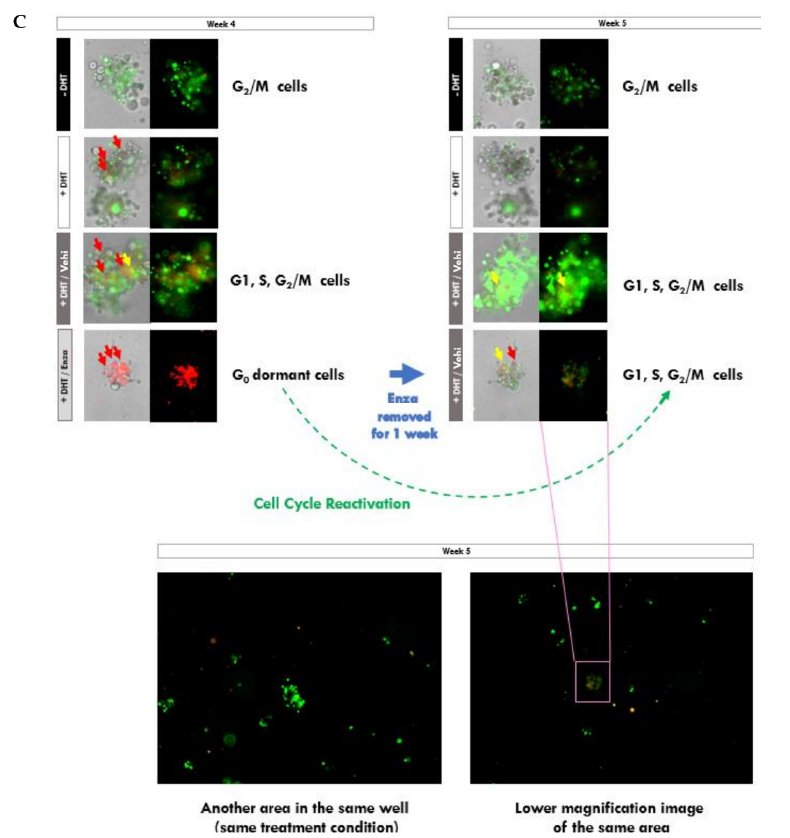
Figure 5. Androgen pathway directed therapy induced a novel population of dormant cells in PDX organoids. ( A ) The Fucci2BL fluorescent, ubiquitination-based cell cycle indicator reporter system visualizes the phase of cell cycle shown by colorimetric signal of red, yellow and green fluorescence for G 1 , G 1 /S and S/G 2 /M, respectively. ( B ) Time course of cell cycle stages in live PCSD1 organoids under the four treatment conditions. Representative images for the same organoids followed through time in each treatment condition at week 1, 2, 3, and 4 of treatment of PCSD1 organoids stably expressing the Fucci2 BL bicistronic fluorescent, ubiquitination-based cell cycle indicator reporter system showing three cell cycle phases: G 1 /G 0 by red fluorescence, G 1 /S by yellow fluorescence and G 2 /M by green fluorescence. The images of bright-field, red fluorescent channel and green fluorescent channel were obtained and merged. ( C ) Removal of enzalutamide led to cell cycle reactivation in dormant PCSD1 organoids. +DHT/enzalutamide containing media was removed from PCSD1 organoids after 4 weeks of treatment and replaced with +DHT/Vehicle media. Microscope images at 4 weeks prior to media change and at 5 weeks after 1 week of removal of enzalutamide containing media are shown for the same